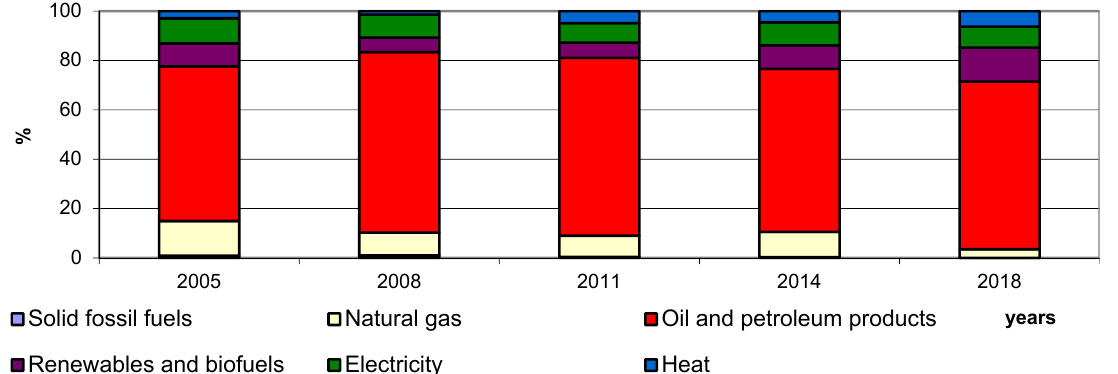
Figure 11. Structure of energy used in agriculture in Latvia in 2005–2018.